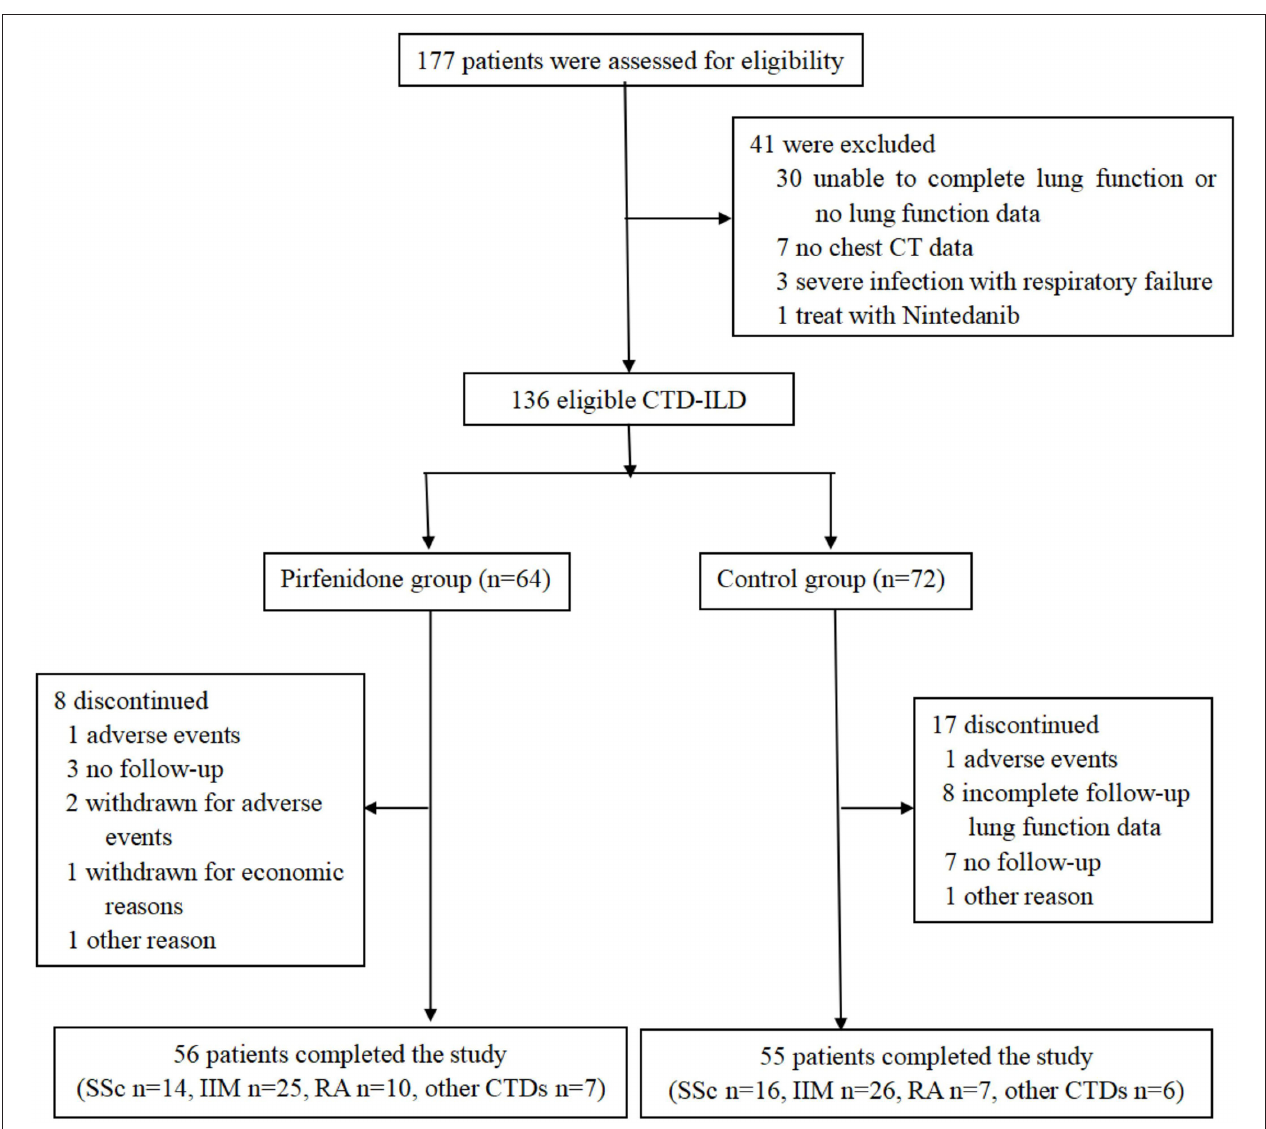
FIGURE 1 | Flowchart of this study.